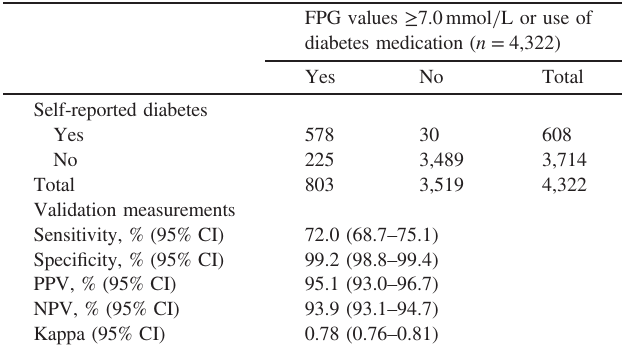
Table 2. Sensitivity and speci fi city analysis in validation study of self-reported type 2 diabetes in Shanghai ( n = 4,322)